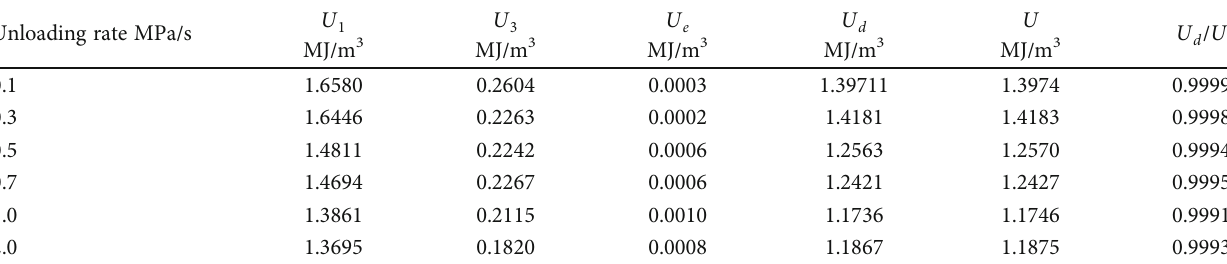
Table 3: Strain energy density at the residual point.